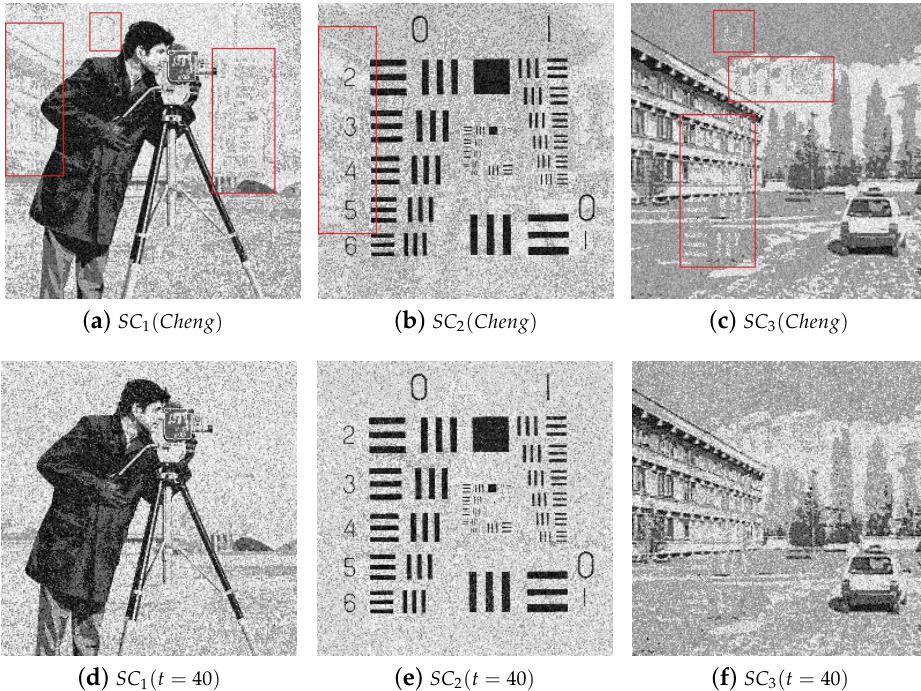
Figure 6. (2,2) threshold experimental comparison results of Cheng et al. and the proposed scheme; ( a – c ) results of Cheng’s scheme; ( d – f ) results of the proposed scheme with t =